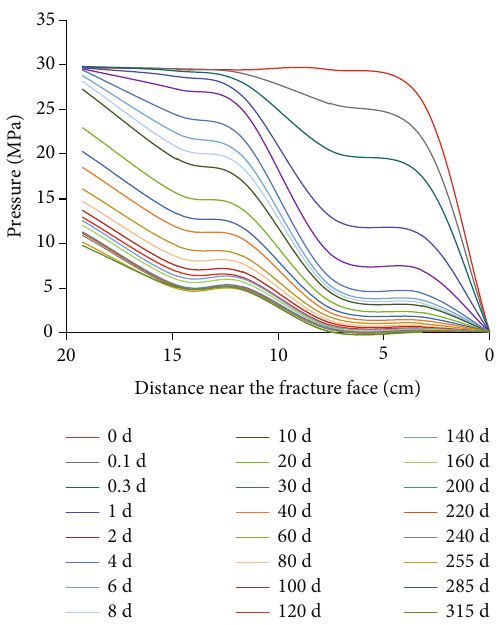
Figure 2: Pressure pro fi le curve with production